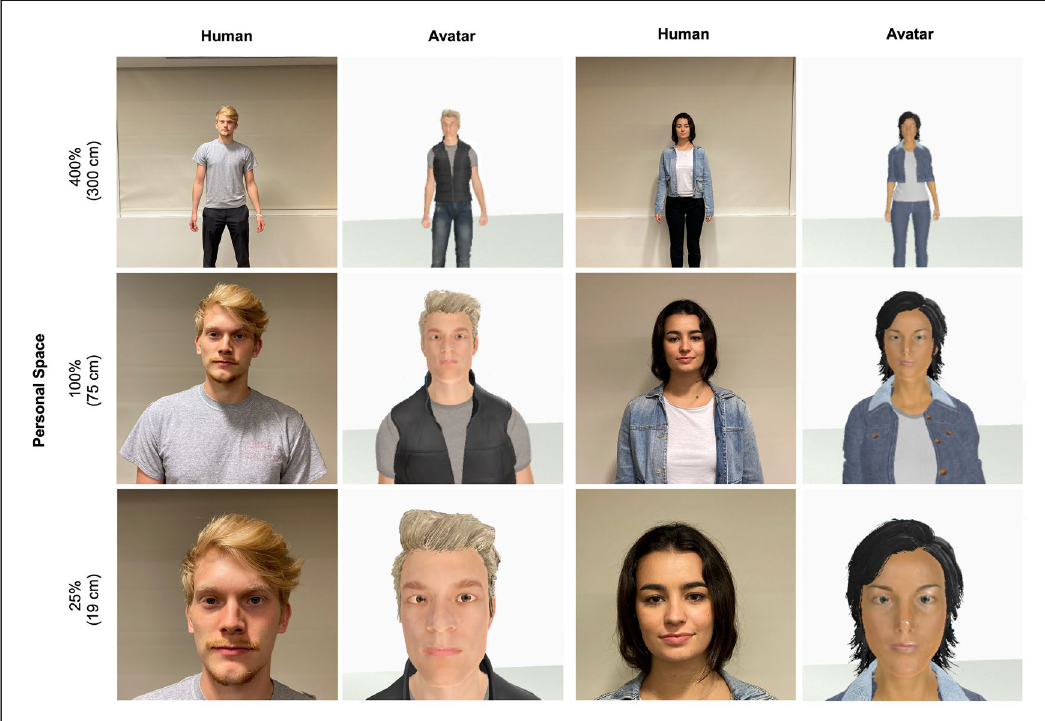
Figure 2. Examples of human and virtual ‘intruders’. The examples shown here include real humans (left and middle right rows, a male and female, respectively) and avatars (middle left and right rows) which served as ‘intruders’ in the Stop Distance Procedures and the Distance Range Experiments. Human and virtual intruders were positioned at systematically varied distances. The distance variations were based on a percentage of each subject’s personal space size. For this illustration, the personal space size was arbitrarily set at 75 cm. The avatars displayed here are highly similar in appearance to the human subjects shown, in order to illustrate minimum possible differences in appearance between the humans and avatars that could be achieved. Despite the similarities of these examples, it is easy to distinguish the avatars from the human subjects. In the actual experiment, the humans and avatars viewed by each participant were not necessarily similar in appearance. Also, additional cues made it trivial to distinguish the real versus virtual intruders (e.g., subjects were clearly aware of whether they were wearing VR goggles, or